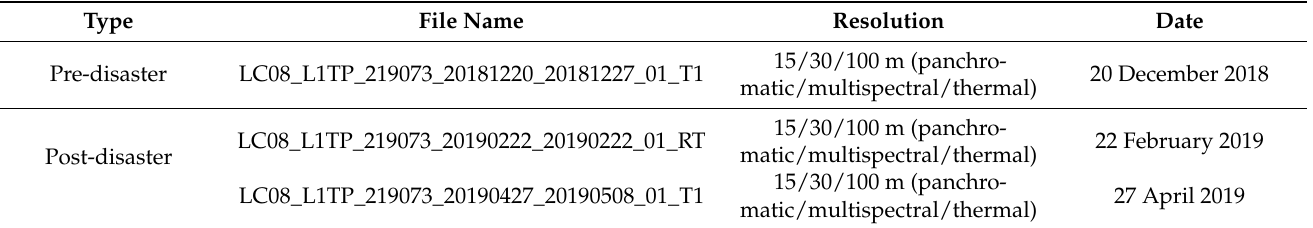
Table 1. Landsat 8 remote sensing images used for the examination of sediment concentration [29].